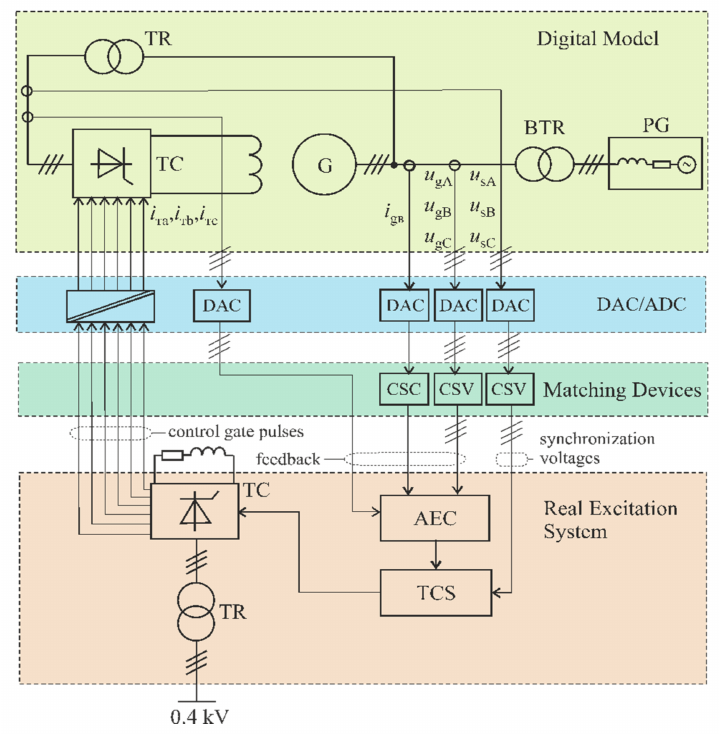
Figure 2. Functional scheme for diagnosing the excitation